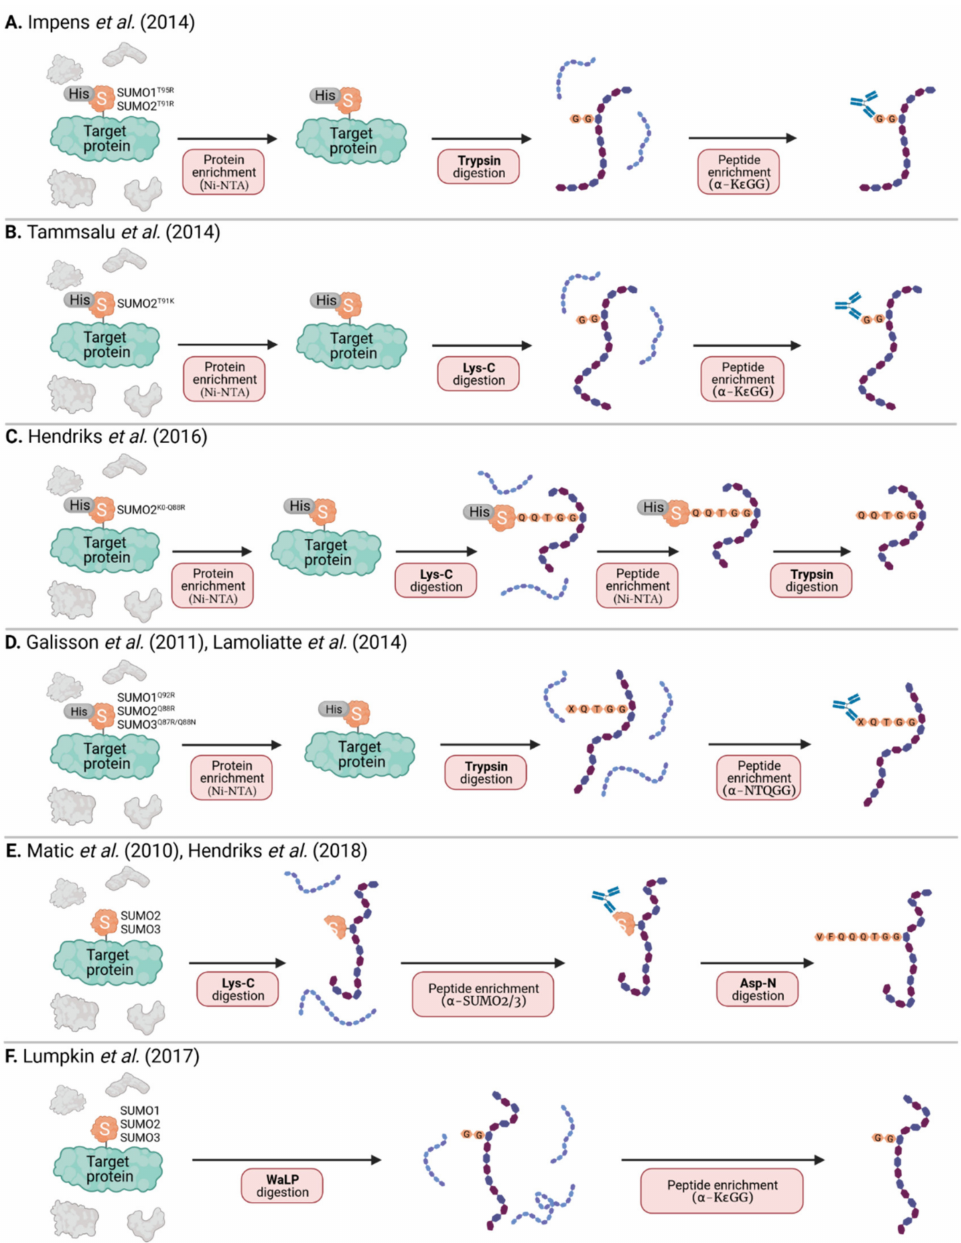
Figure 4. MS-based strategies to identify specific SUMOylation sites. ( A ) His6-SUMO1-T95R or HisSUMO2-T91R modified proteins are purified by Ni-NTA, digested with trypsin, and peptides containing the di-glycine remnant are enriched using a specific α -K ε GG antibody. ( B ) His6-SUMO2 T91K modified proteins are purified by Ni-NTA, digested with Lys-C, and peptides containing the diglycine remnant are enriched using a specific α -K ε GG antibody. ( C ) Proteins modified with His10-SUMO2-K0-Q88R (K0 = all K residues mutated to R) are purified by Ni-NTA and digested with Lys-C. Peptides containing the intact His10-SUMO modification are then enriched by a second Ni-NTA purification step before trypsin digest. ( D ) His6-SUMO1 Q92R, His6-SUMO2 Q88R and His6-SUMO3 QQ87/88RN modified proteins are purified by Ni-NTA, digested with trypsin, and peptides containing a (X)QTGG remnant are enriched using a specific α -NQTGG antibody. ( E ) Target proteins modified with endogenous SUMO are digested with Lys-C. Peptides containing a SUMO fragment (with the intact SUMO2/3 antibody epitope) are then immunoaffinity-purified before a second digestion step with Asp-N. ( F ) Target proteins modified with endogenous SUMO are digested with the endoproteinase WaLP, and peptides containing the di-glycine remnant are enriched using a specific α -K ε GG antibody. For all methods ( A – F ), enriched peptides are analyzed by mass spectrometry (MS) for identification and